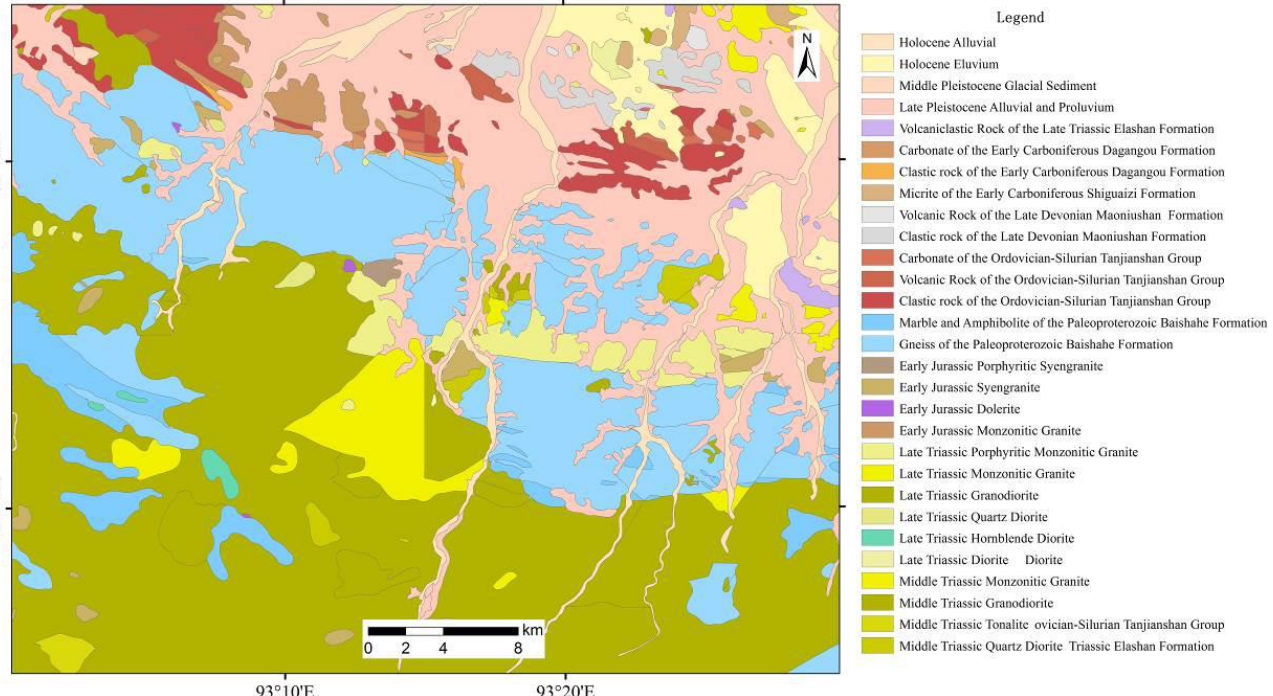
Figure 2. Simplified geologic map of the study area.